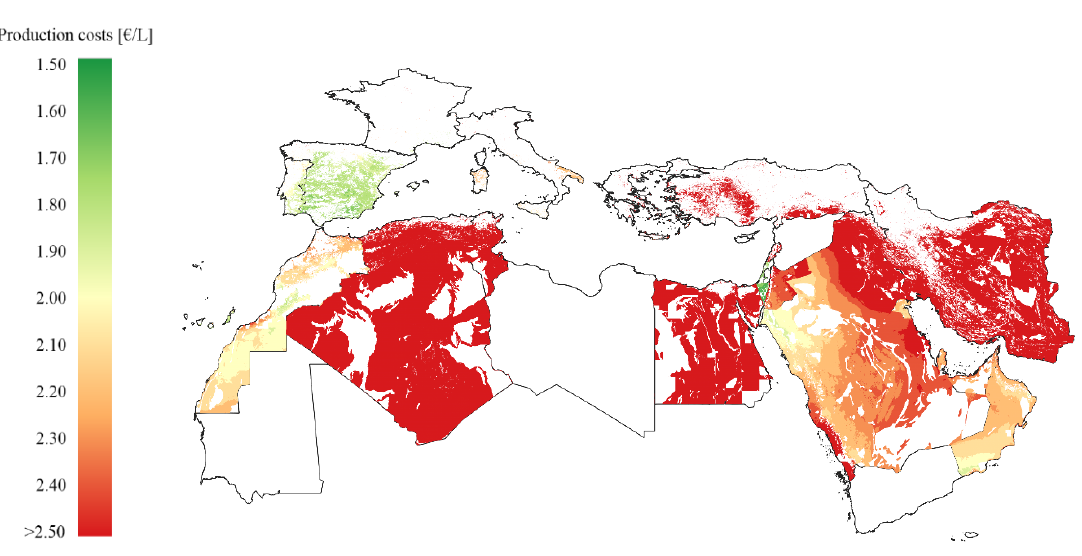
Figure A6. Production costs of solar thermochemical jet fuel in the MED region. Mauretania, Lybia, Syria, Palestine, and Yemen have been excluded from the analysis.